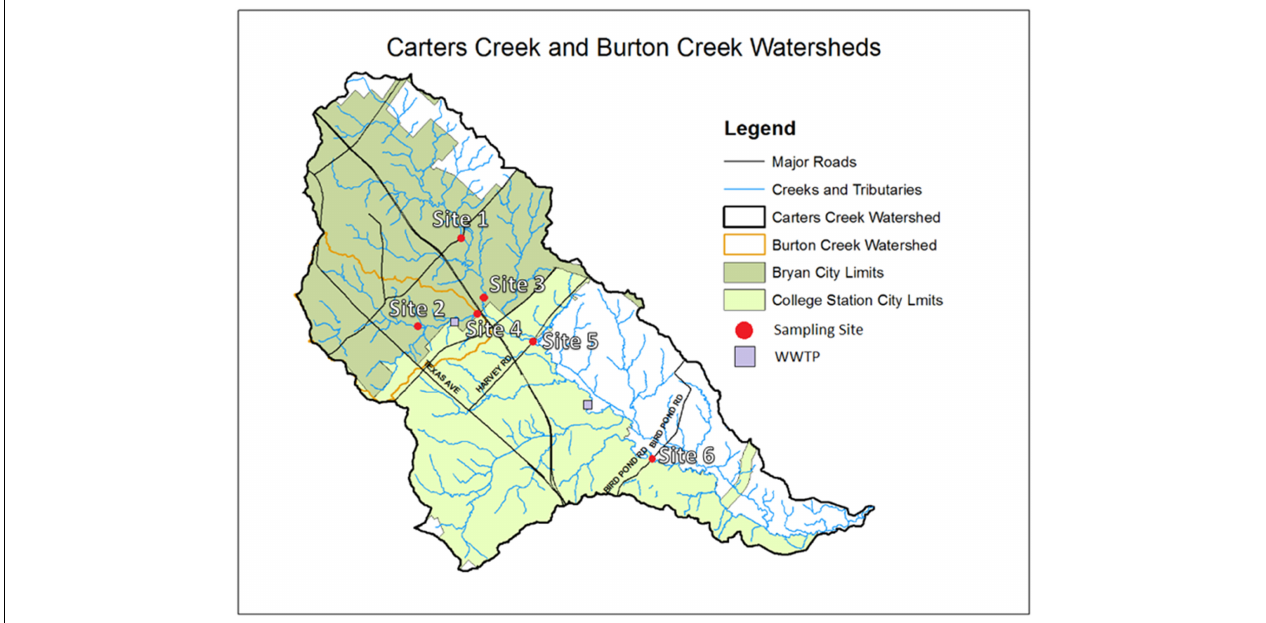
FIGURE 1 | Map of the Carters Creek Watershed and locations of the six sampling sites and the two WWTPs.